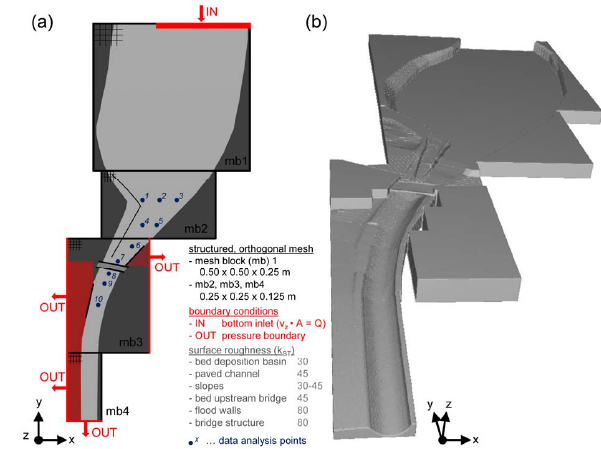
Fig. 3. (a) Scheme of the 3-D numerical model set up with the FLOW-3D software; (b) preview of the discretised geometry (FAVOR-model)